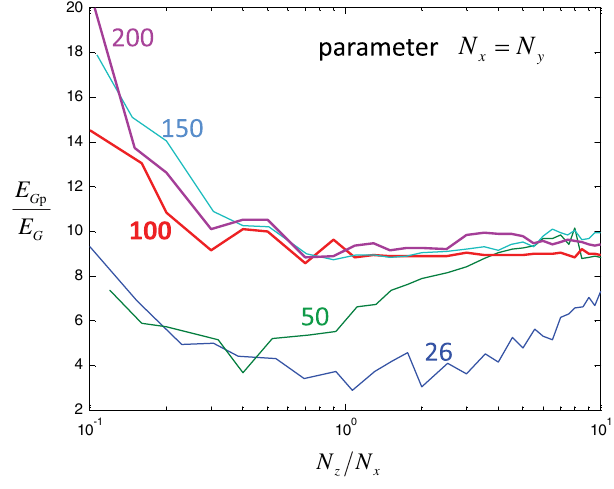
=E to compute the Green ’ s Gp G × N × N points and x y z Δ z e N p ¼ z z